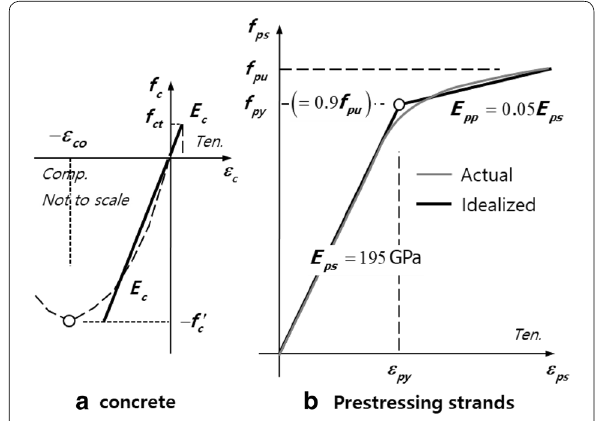
Fig. 9 Uniaxial behavior of concrete and PS strand for design.